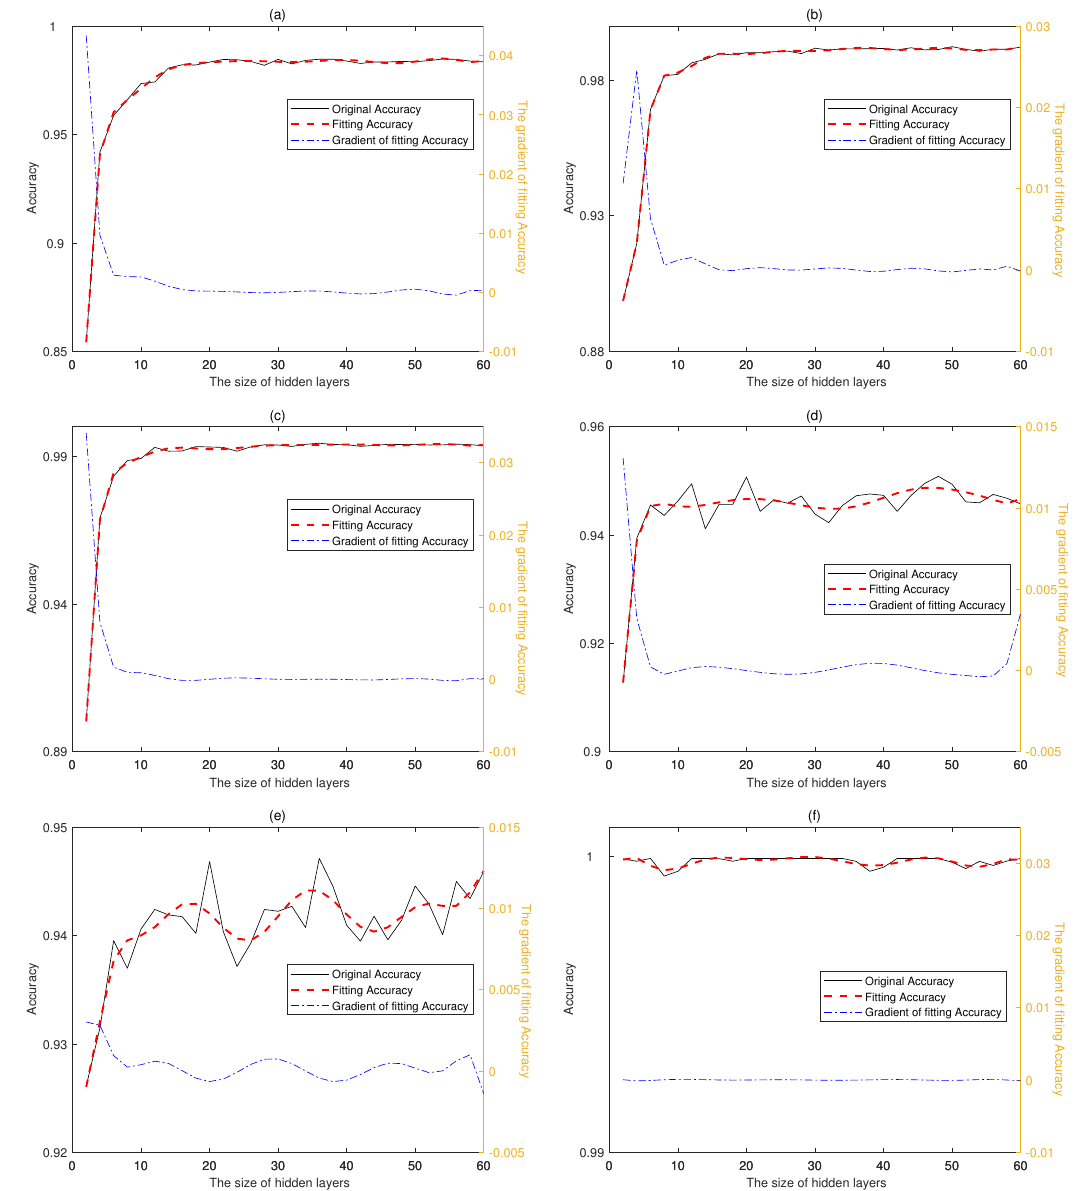
Figure 3. Accuracies of multi-classifiers with different hidden layer sizes. The accuracies variation of classifier 1 ( a ), 2 ( b ), 3 ( c ), 4 ( d ), 5 ( e ), 6 ( f ) corresponding to activity 1, 2, 3, 4, 5, 6 in UCI-HAR